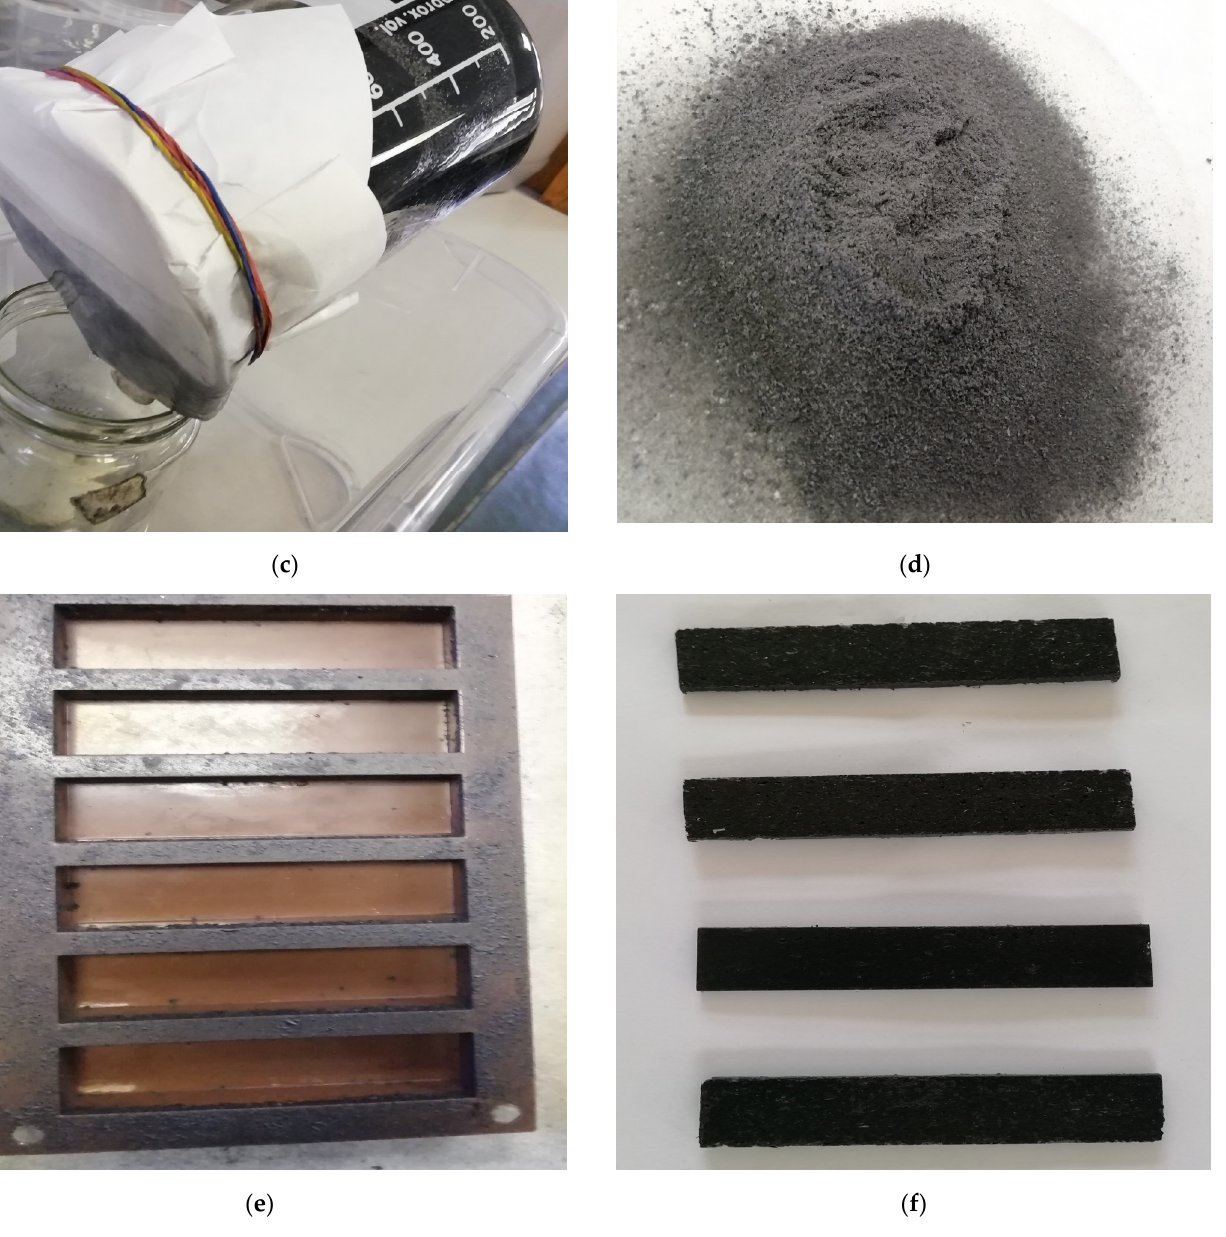
Figure 1. Fabrication procedures for CF/LLDPE composites: ( a ) CF/IPA mixture; ( b ) CF/IPA/PE mixture after ultrasonication; ( c ) filtration of CF/IPA/PE mixture, ( d ) final dried powder for fabrication, ( e ) silicon mold for fabrication and ( f ) CF/PE composites after fabrication process.